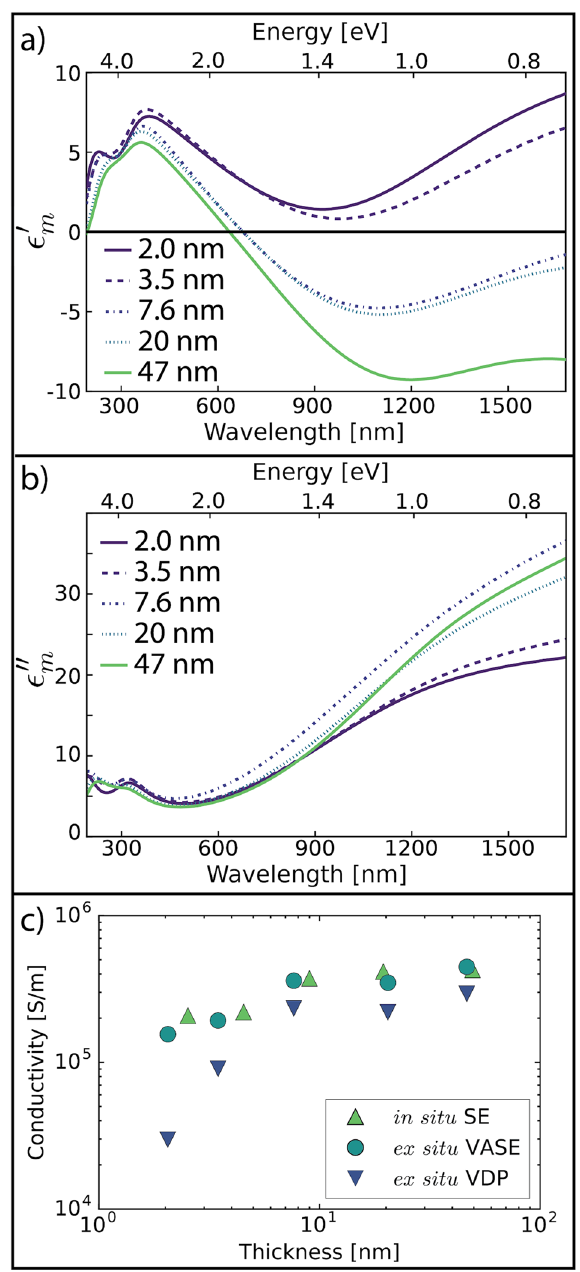
Figure 2. Dielectric function and conductivity. Optical and electronic properties of TiN thin films deposited on SiO 2 -coated silicon substrates. The real ( a ) and imaginary ( b ) parts of the dielectric function fit to ex situ VASE data for each TiN film thickness (2–47 nm). ( c ) Spectroscopic ellipsometry was also used to measure the film thickness and conductivity both in situ (green upright triangle) and after deposition and exposure to air using the VASE method (blue circle). These optical measurements of conductivity are compared to electrical transport measurements performed using the van der Pauw (VDP) method (inverted purple